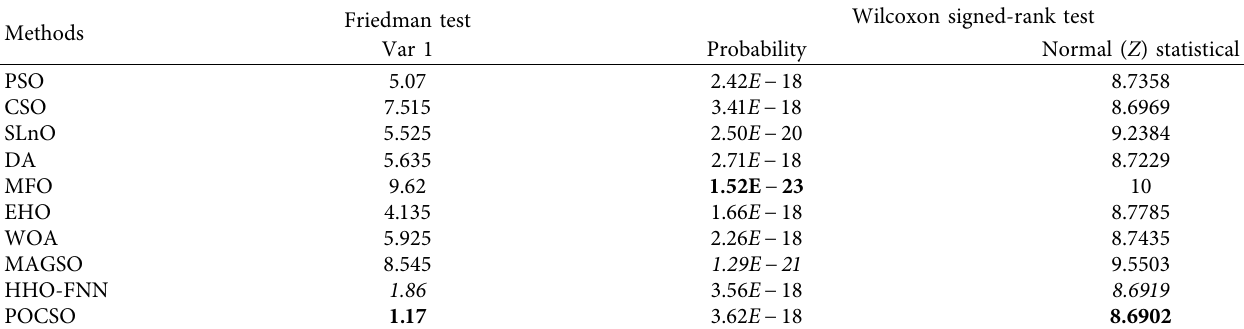
Table 13: Nonparametric statistical analysis for IEEE-30 bus system.